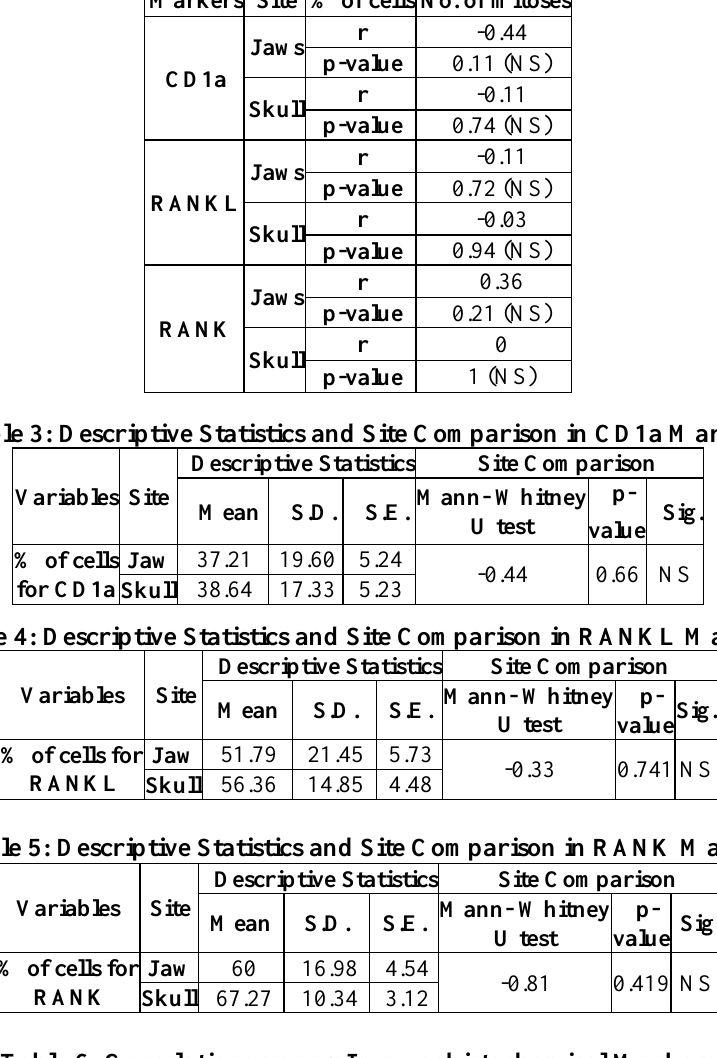
Table 6: Correlations among Immunohistochemical Markers Jaws